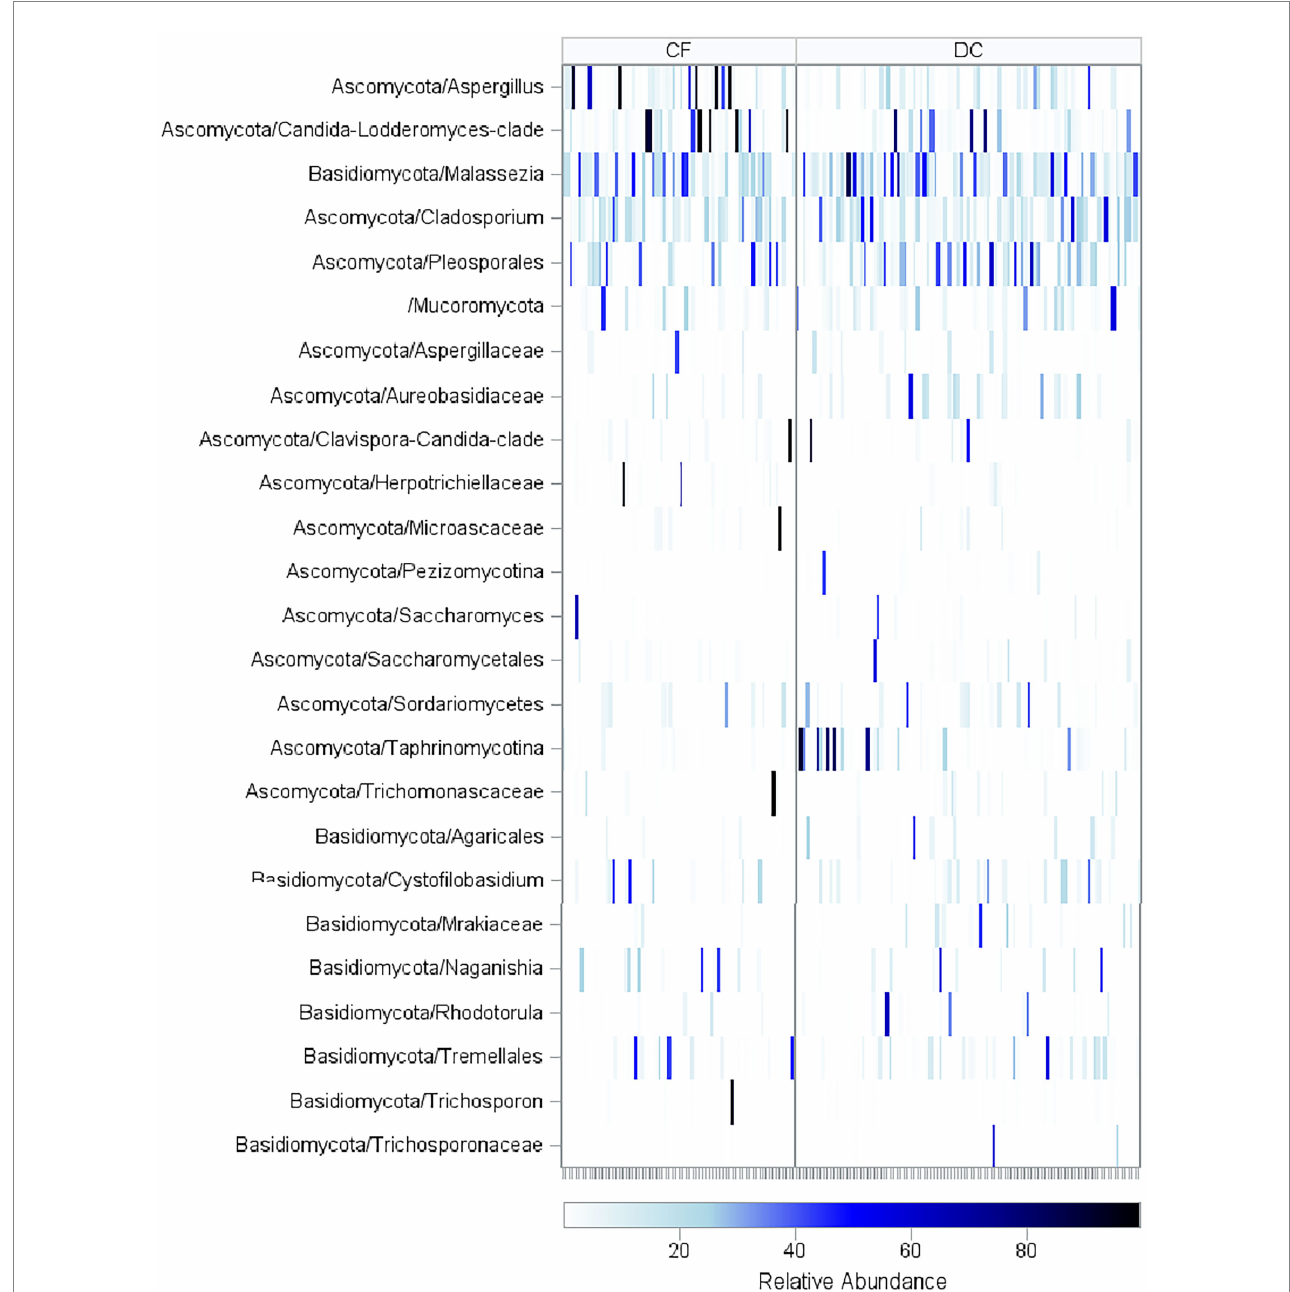
FIGURE 3 Relative abundance of fungal taxa across age. Heatmap of sequencing results for all BALF samples in CF and DC groups with samples arranged in order of increasing age (in years). Fungal Taxa that had a relative abundance of over 40% in at least one of the samples are included. PWCF had higher relative abundance of Candida-Lodderomyces -clade (Wilcoxon, p = 0.01) and Aspergillus (Wilcoxon, p = 0.06). The taxonomic OTUs reflect the resolution available from information content of the sequences and represent mutually exclusive groups, there is no overlap between sequencing counts due to placement in the taxonomic